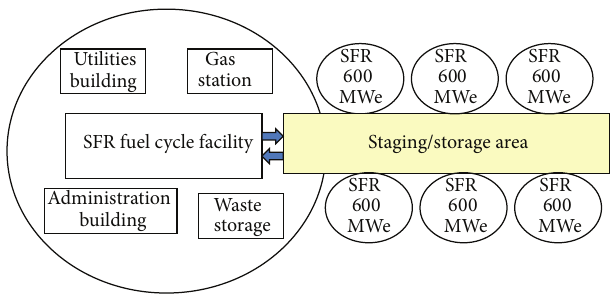
Figure 1: The sketch of SFR fuel cycle facility.